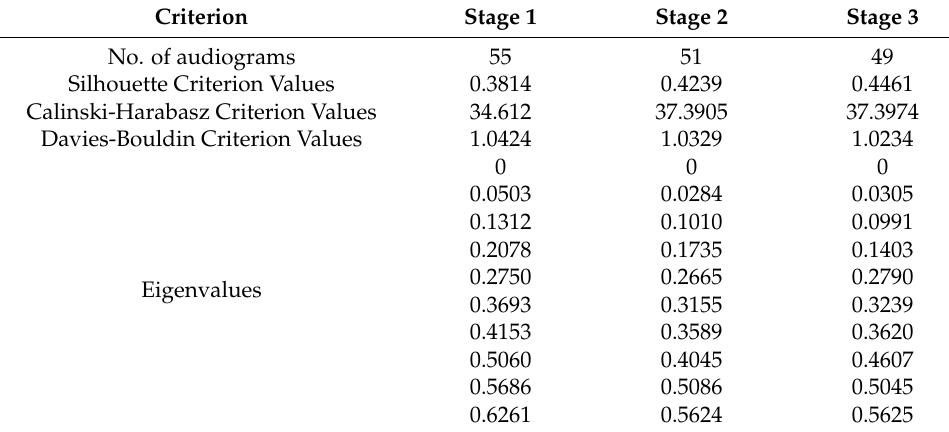
Figure 4. Silhouette plots for 10 clusters. Table 4. Different clustering evaluation criteria for 10 clusters. Table 4. Different clustering evaluation criteria for 10